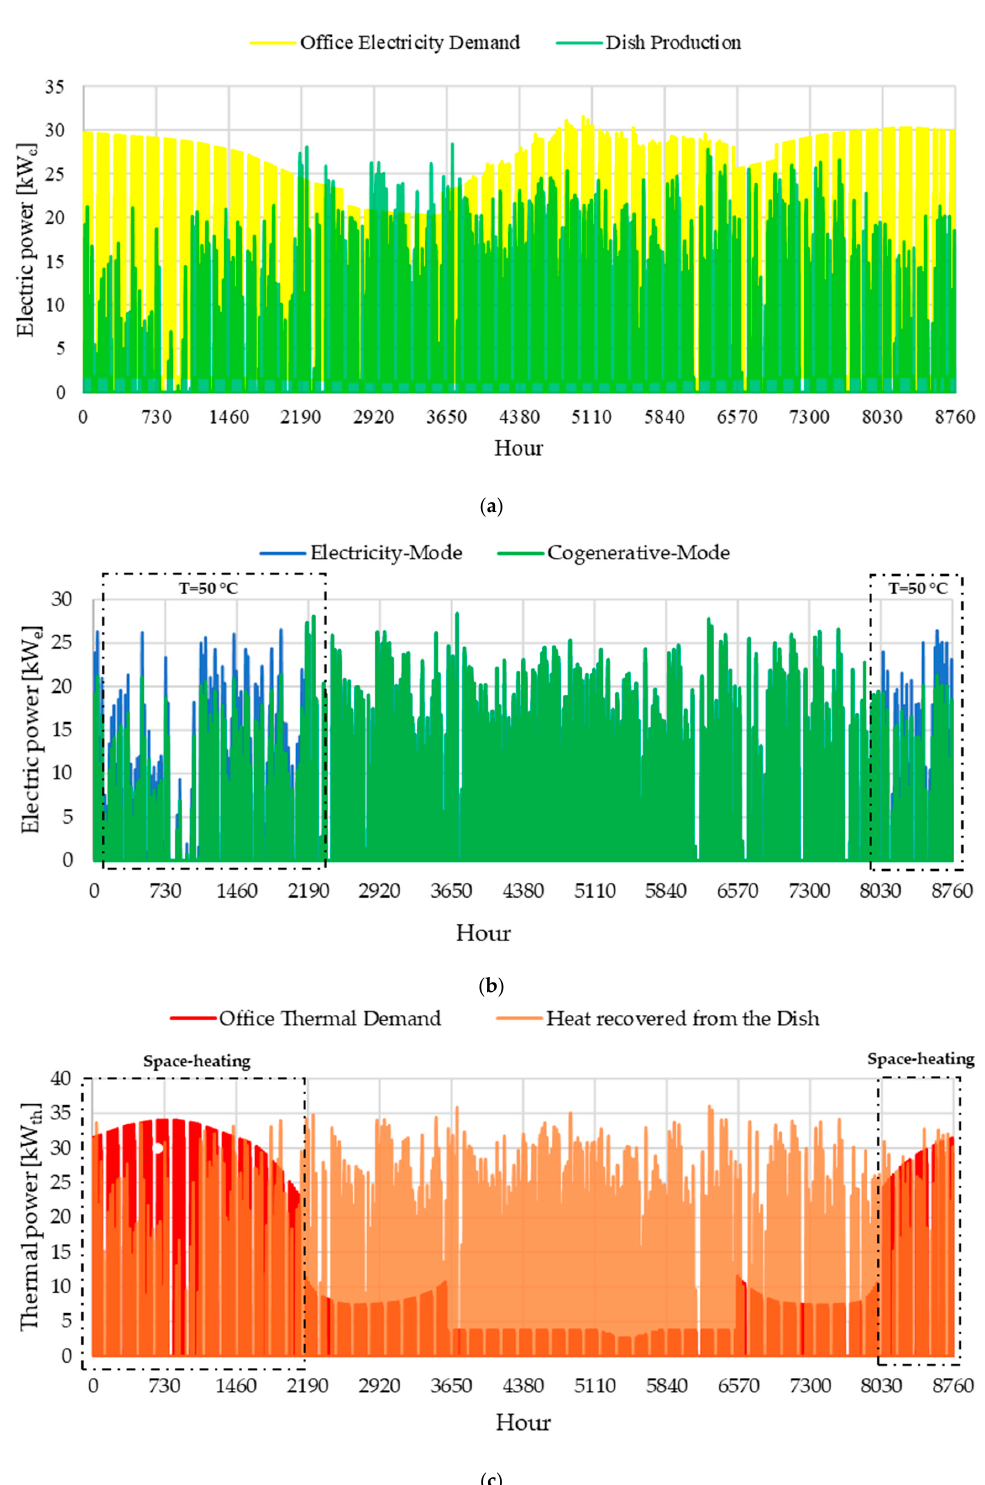
Figure 10. Scenario no. 1-B: ( a ) profiles of annual electricity demand and dish-Stirling production, ( b ) electricity profile of dish-Stirling production in electricity mode and the one obtained for cogenerative mode and ( c ) profile of office thermal demand and heat recovered from dish-Stirling.